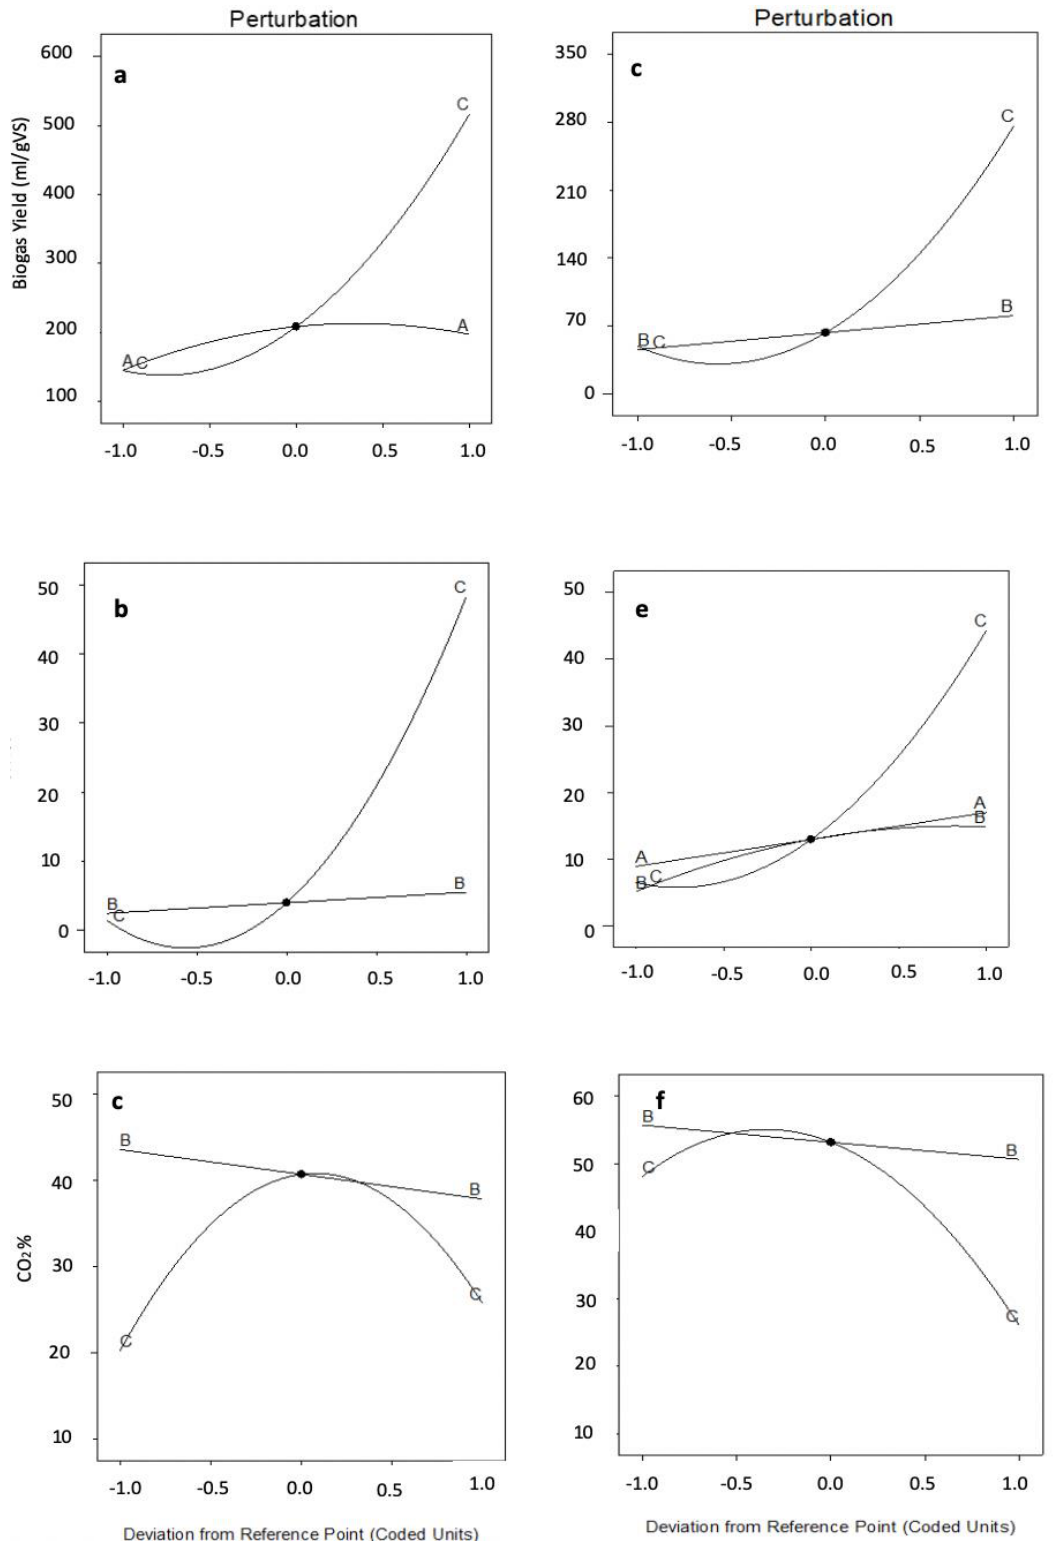
Figure 8. Perturbation graphs for AD of pot ale and spent grain pot ale mix on biogas yield ( a , d ), CH4% ( b , e ), and CO2% ( c , f ) respectively.